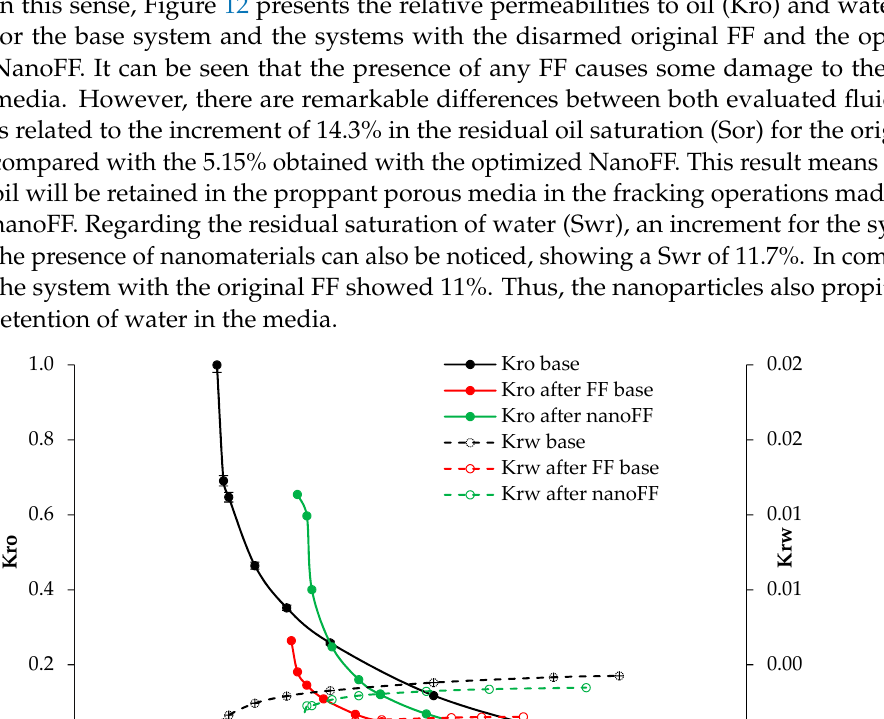
Figure 13. Formation damage behavior at different water saturations for the test carried out with the original and optimized NanoFF in the proppant porous media.